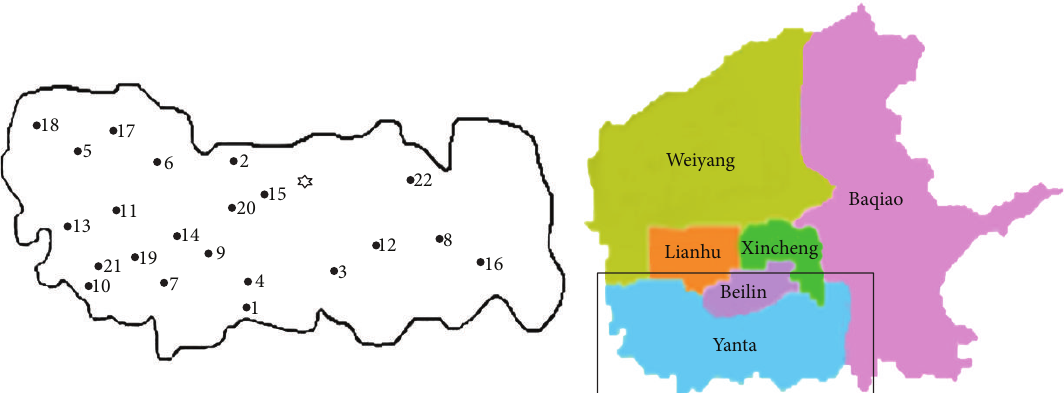
Figure 2: Study area (black circles indicated the sampling sites with different pollution level; asterisk indicated the sampling site of Xi’an University of Architecture and